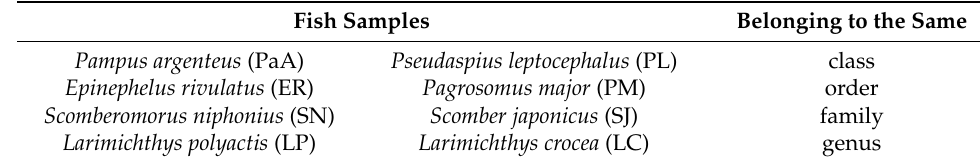
Table 2. Model fish samples at different levels in the present study.